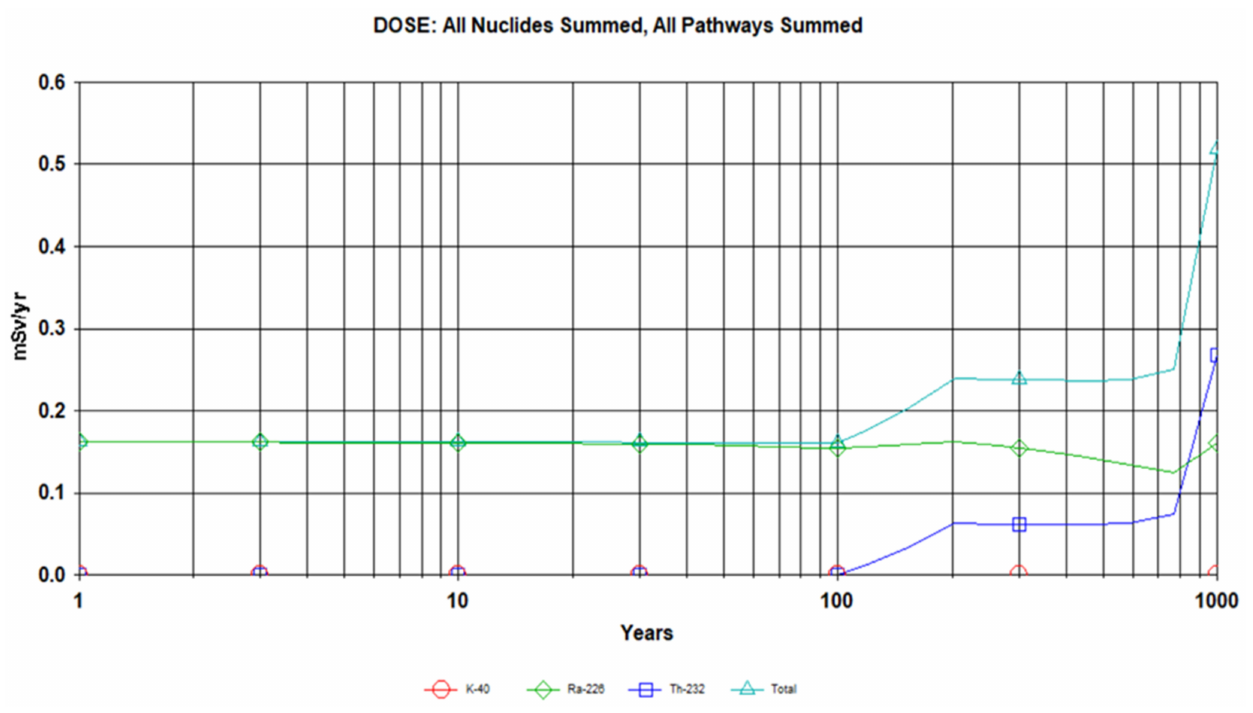
Figure 9. Total dose of all nuclides using a cover thickness of 1